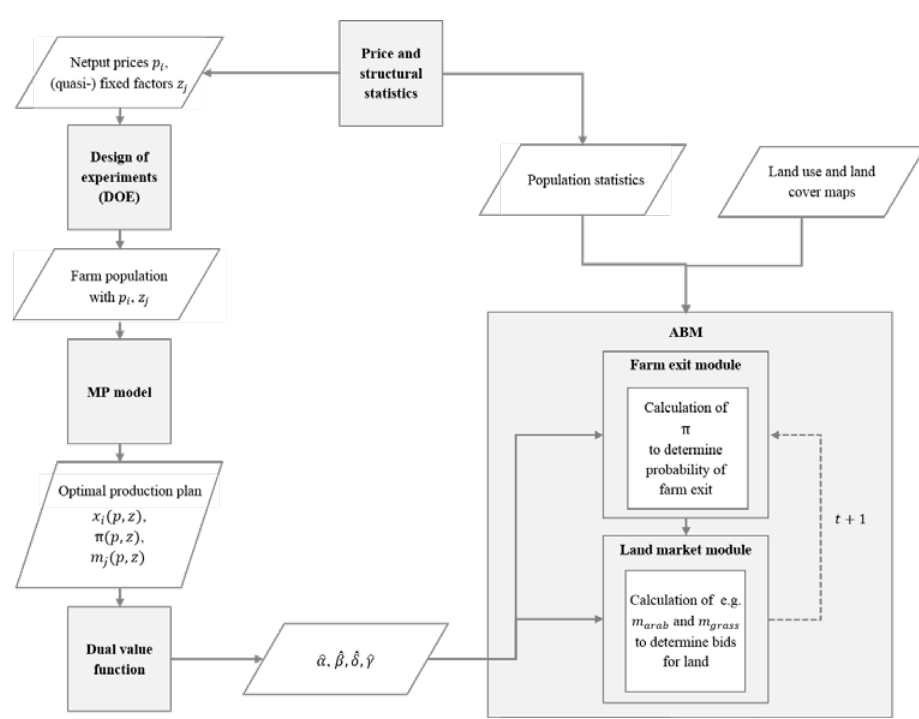
Figure 2. Meta-modeling